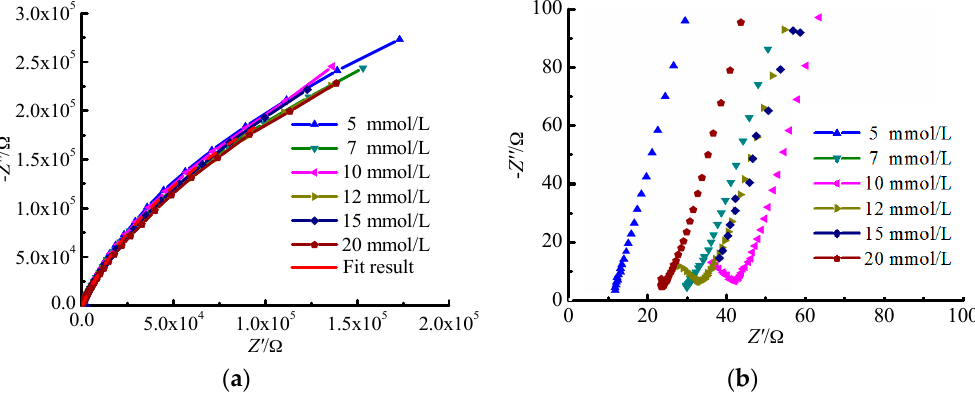
Figure 1. Nyquist figure and enlarged view of high frequency area for TA2 under different glucose concentrations. ( a ) Nyquist figure; and ( b ) enlarged view of high frequency area.